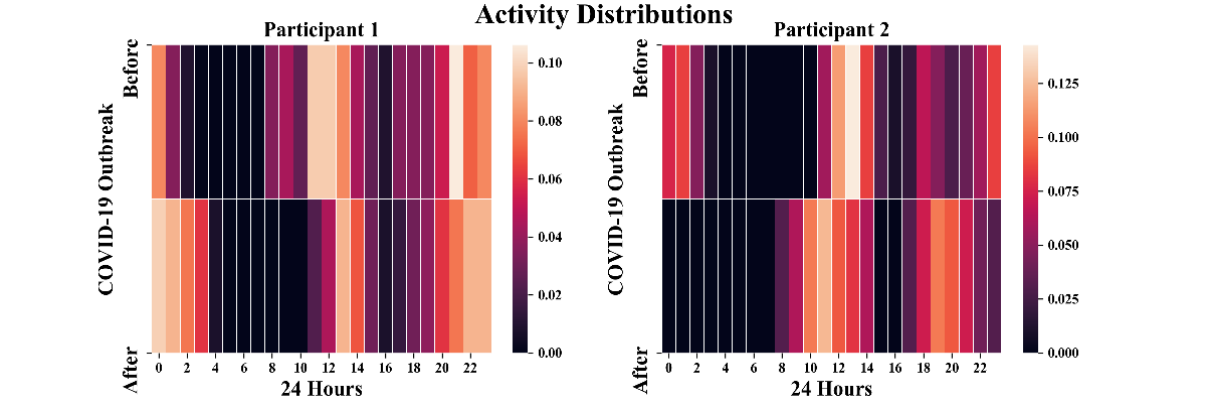
Figure 2. The normalized activity distributions over 24 hours before and after the outbreak of COVID-19 for two example participants.